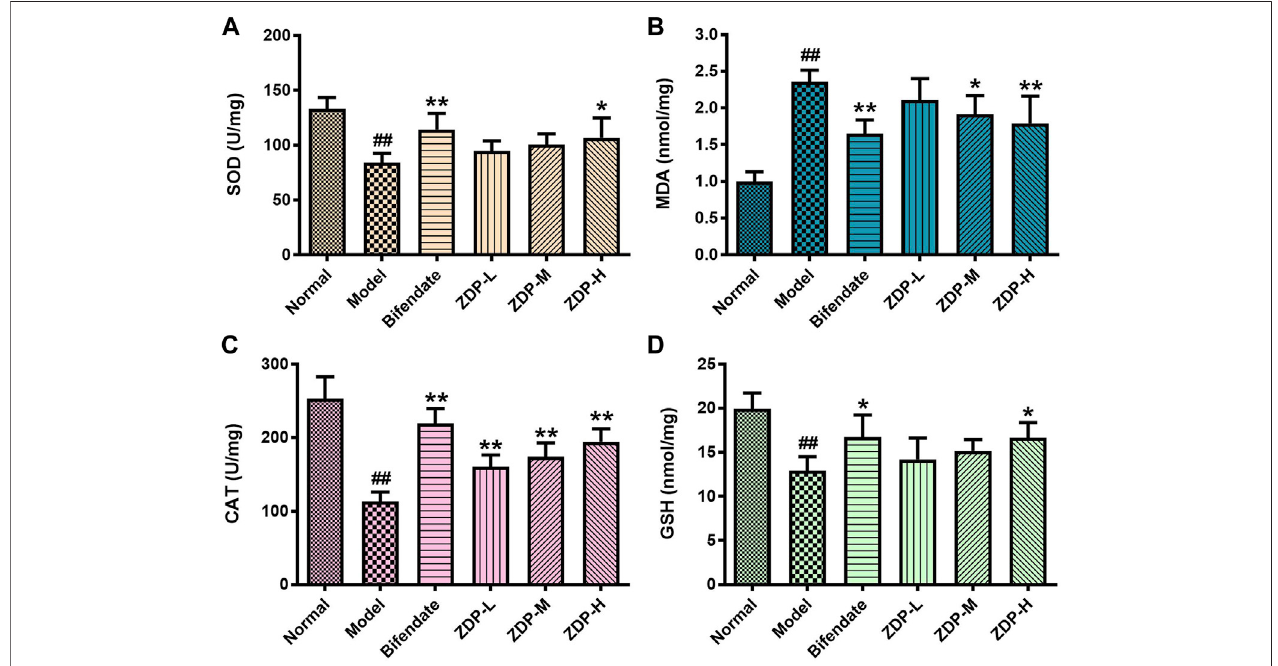
FIGURE 5 | Effects of ZDP on the activity of liver SOD, MDA, CAT and GSH in the murine model of ALI induced by CCl 4 . SOD (A) , MDA (B) , CAT (C) and GSH (D) activitiesweremeasuredinhepatictissuesamples(Normalcontrol,Modelcontrol,Bifendate-treatedcontrol,ZDP-L,ZDP-MandZDP-H)byELISA.Datafromsixtoeight miceper groupareexpressedasthemean ± SD.Statisticalanalysis: ## p < 0.01comparedwiththenormalgroup;* p < 0.05,** p < 0.01compared withthemodelgroup, One-Way ANOVA.